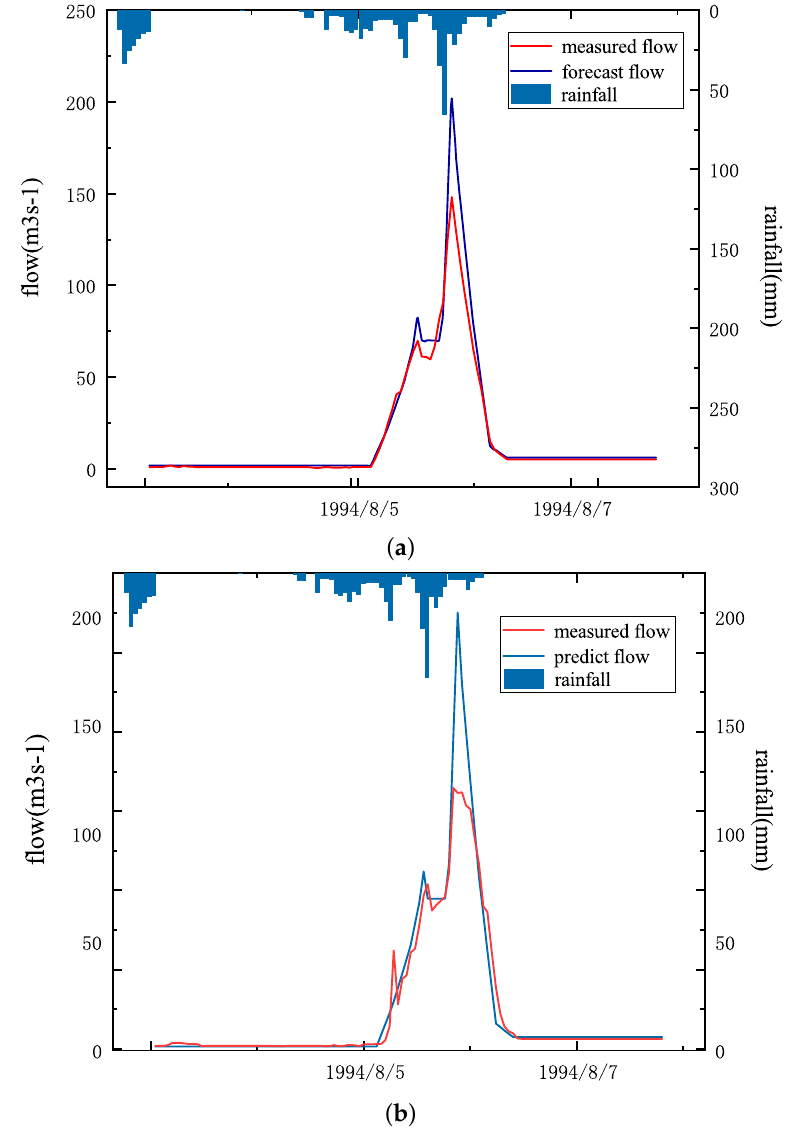
Figure 9. The forecasting process of the No. 19940805 flood. ( a ) Flood forecast results of No. 19940805 flood under the BP neural network model. ( b ) Flood forecast results of No. 19940805 flood under the random forest model. Among them, the blue line is the measured flow at the Zhaishang station, the red line is the predicted flow at the Zhaishang station, and the blue histogram is the rainfall value in the